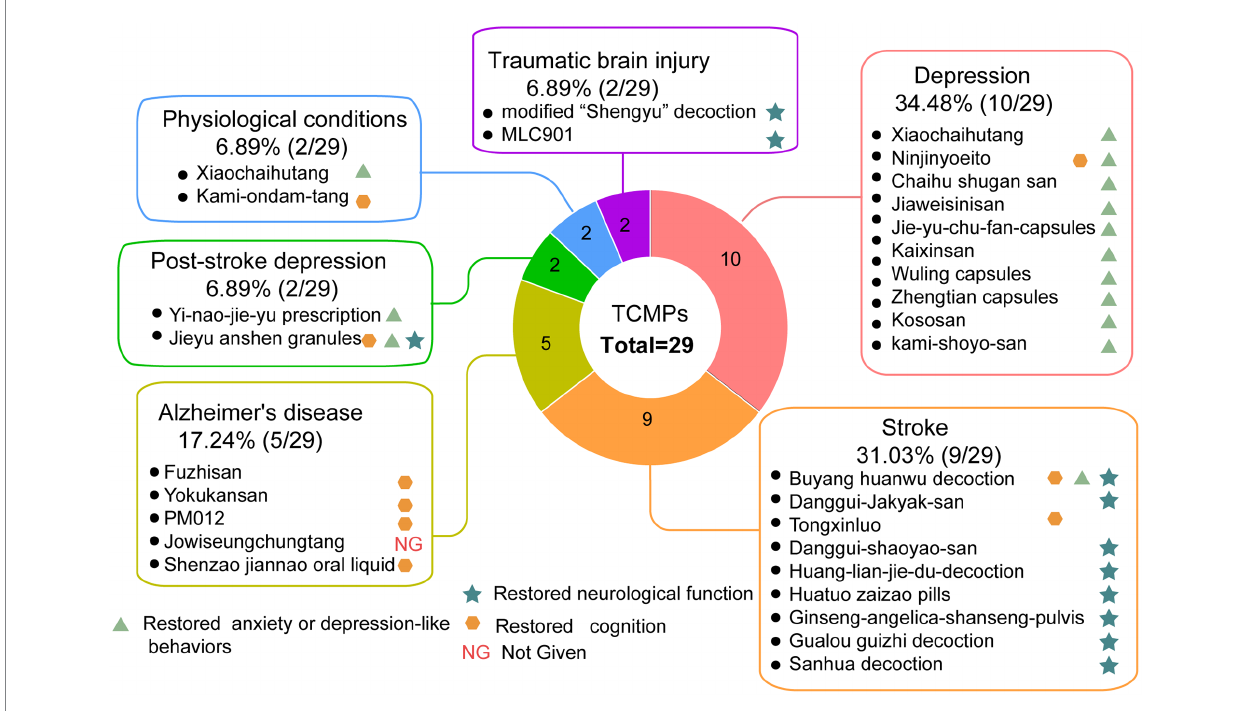
FIGURE 2 Pie chart of TCMPs improving adult neurogenesis and brain function, n = 29. Xiaochaihutang improves adult neurogenesis in stroke and physiological conditions, so it was counted in two cases for two